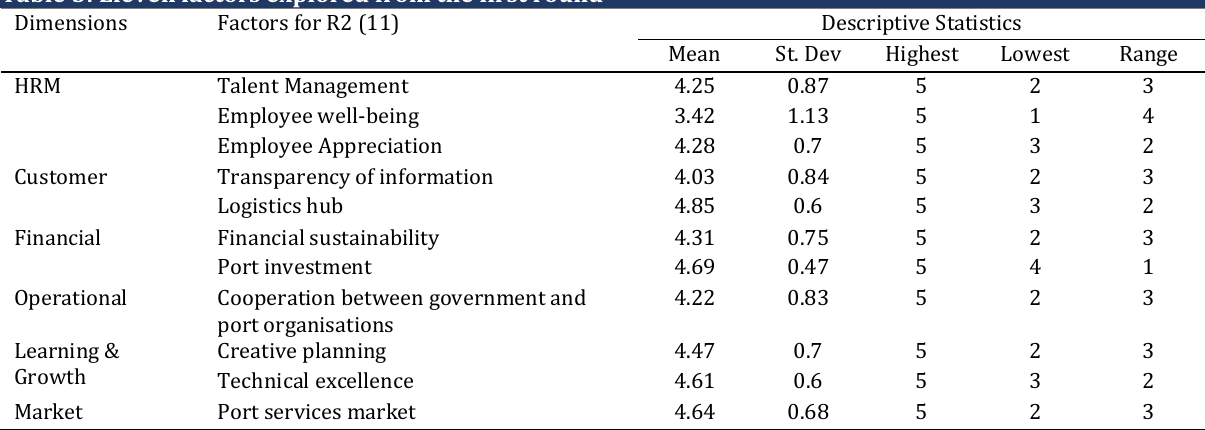
Table 5: Eleven factors explored from the first round Dimensions Factors for R2 (11) Descriptive